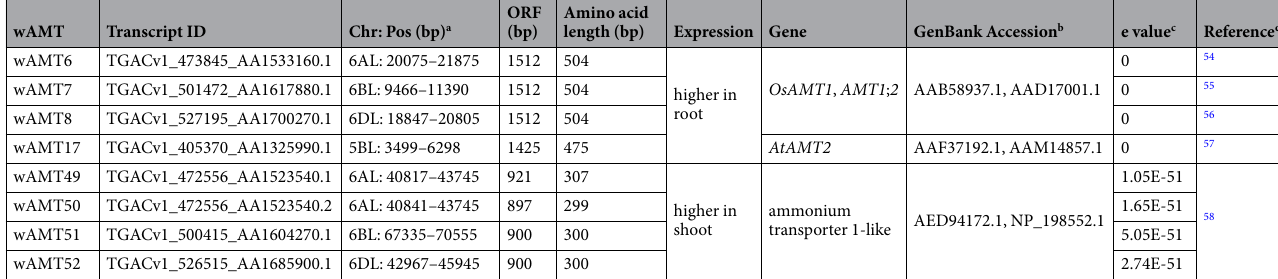
Table 2. Annotation information of differentially expressed ammonium transport genes in root and shoot of five wheat seedlings. a Chromosome labeled ‘U’ indicates an unknown map position for the scaffold housing the corresponding transcript ID. b Only the two best hits from blastx are shown. c The highest value is shown if the blastx results had different e-values. d ‘NCBI’ is listed as the reference for genes that were either unpublished or directly deposited into